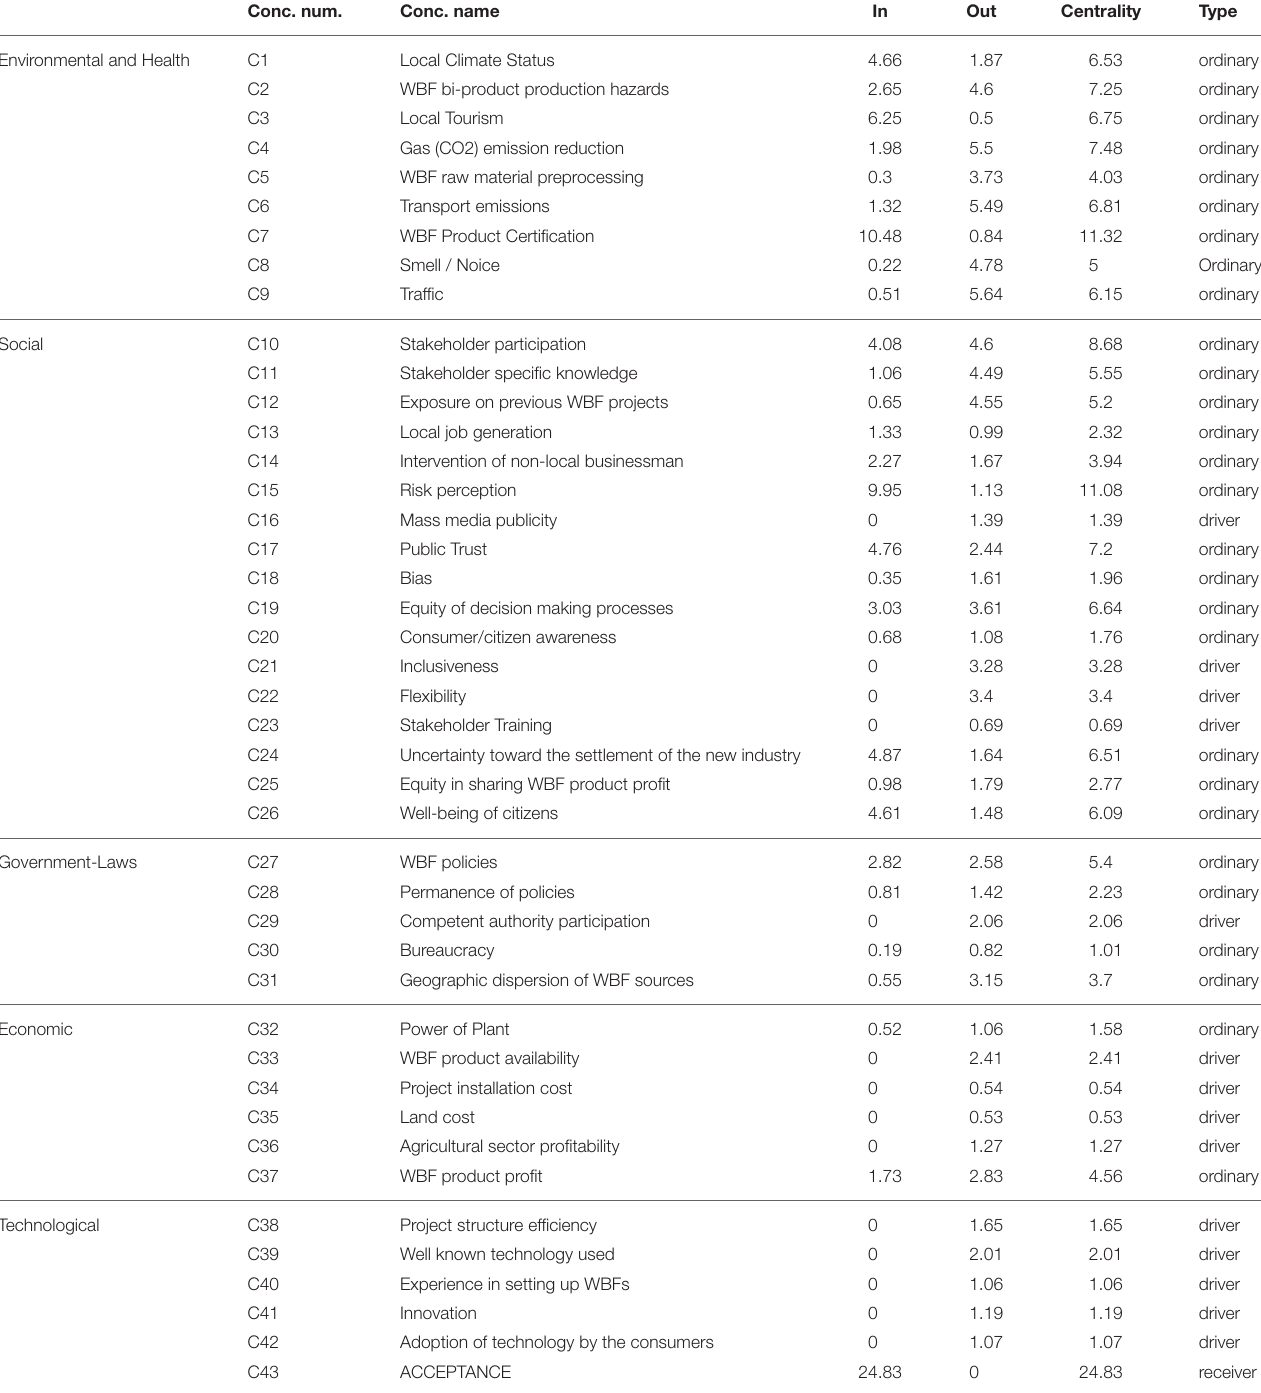
TABLE 2 | Categorization, InDegree, OutDegree, Centrality and Type of Concepts in the FCM. Conc.